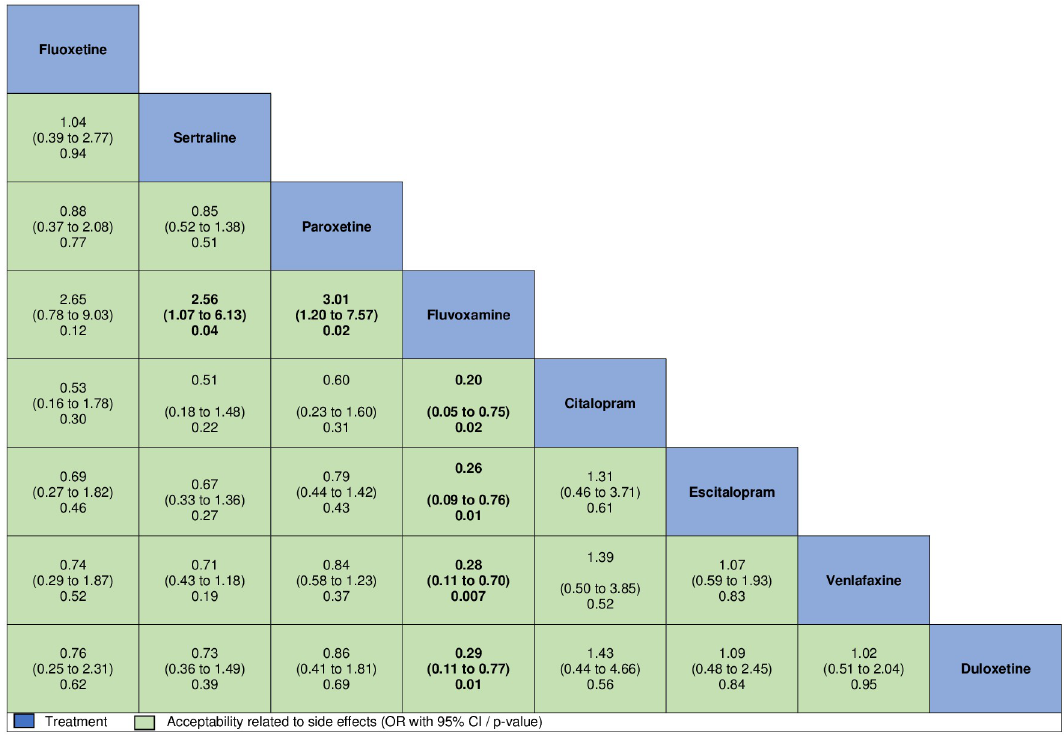
Fig 5. Comparisons of discontinuation rates due to adverse events of all selective serotonin reuptake inhibitors and serotonin and norepinephrine reuptake inhibitors, considering 3-level multiple meta-regression models. Comparisons between treatments should be read from left to right, and the estimate is in the cell in common between the column-defining treatment and the row- defining treatment. Odds ratios (ORs) above 1 favor the column-defining treatment.